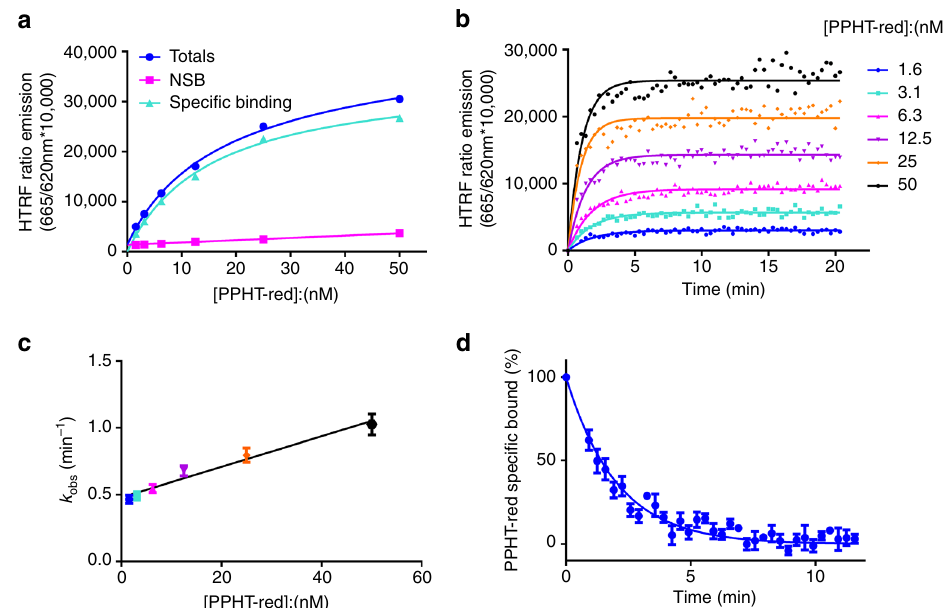
Fig. 1 Determination of PPHT-red equilibrium and kinetic binding parameters. a Saturation analysis showing the binding of PPHT-red to the human dopamine D 2 R. CHO – D 2 R cell membranes (2 μ g per well) were incubated for 120 min with gentle agitation with increasing concentrations of PPHT-red. Data are presented in singlet form from a representative of 13 experiments. b Observed association of PPHT-red binding to the human dopamine D 2 R. Data are presented in singlet form from a representative of 13 experiments. c Plot of PPHT-red concentration vs. k obs . Binding followed a simple law of mass action model, k obs increasing in a linear manner with fl uorescent ligand concentration. Data are presented as mean ± s.e.m. from a total of 13 experiments. d PPHT-red dissociation following addition of haloperidol (10 μ M). Dissociation data are presented in mean ± s.e.m. from four experiments performed in singlet. All binding reactions were performed in the presence of GppNHp (100 μ M) with nonspeci fi c-binding levels determined by inclusion of haloperidol (10 μ